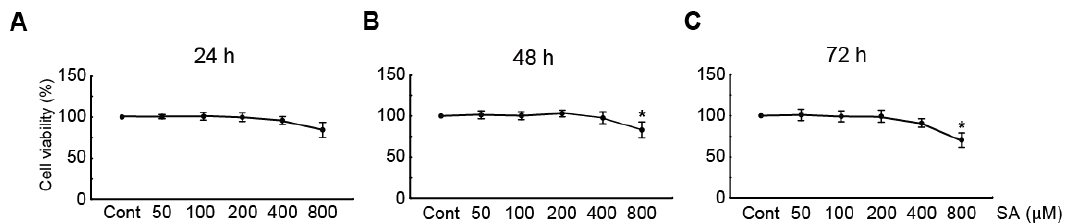
Figure 1. Cytotoxic effects of SA in neonatal rat cardiomyocytes. The MTT assay was performed for measuring the cell viability of cardiomyocytes, using DMSO (a vehicle-treated control) or SA at 50, 100, 200, 400, and 800 μM for ( A ) 24, ( B ) 48, and ( C ) 72 h. Data are expressed as the mean ± standard error of the mean (SEM). Significance was measured by one-way analysis of variance (ANOVA) with a Bonferroni post hoc test. * P < 0.05 vs. control group. Cont, control; SA, sinapic acid; MTT, 3-[4,5-dimethylthiazol-2-yl]-2,5-diphenyltetrazolium